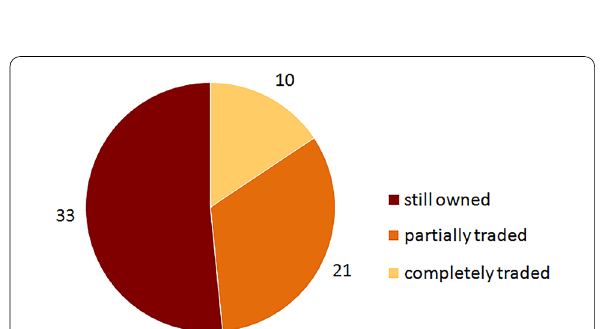
Fig. 6 Number of companies that have not used DRs in construction practices, according to the current status of possession of certificates